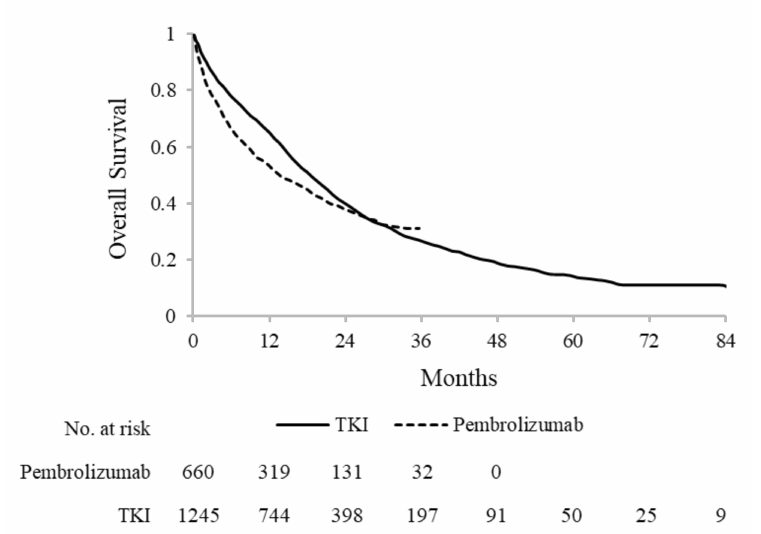
Figure 3. Kaplan-Meier estimates of overall survival among 660 and 1245 advanced NSCLC patients treated, respectively, with first-line pembrolizumab and tyrosine-kinase inhibitors